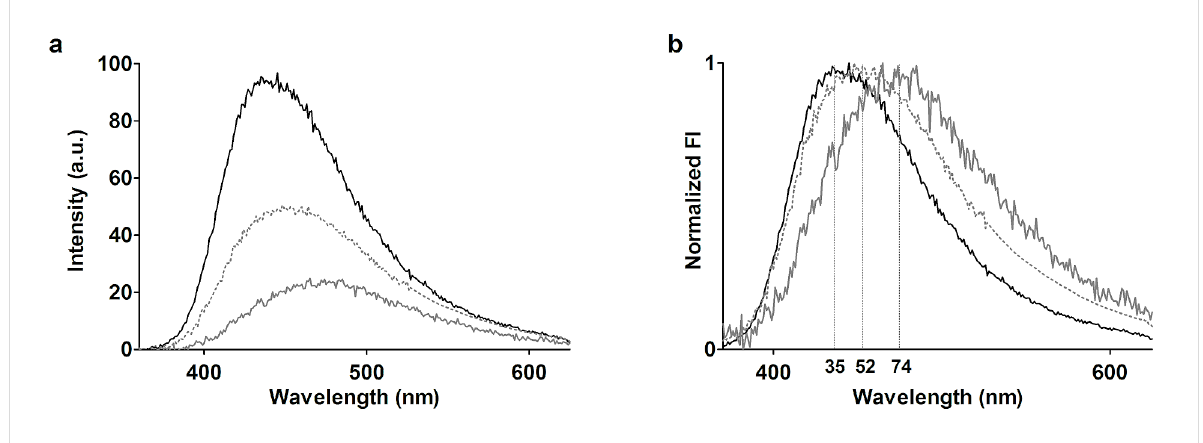
Figure 7: (a) Steady-state TIRF emission spectra of 1 mM 2,6-ANS in PBS, recorded on a bare quartz slide (solid grey), and azide-functionalized quartz slides grafted with PA (dotted grey) and the β -CD dimer (solid black). The corresponding normalized spectra are given in (b). The emission maxima are listed in the order 474, 452 and 435 nm.